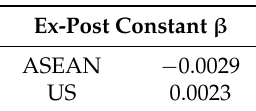
Table 3. Average out of sample difference of the ex-post constant beta